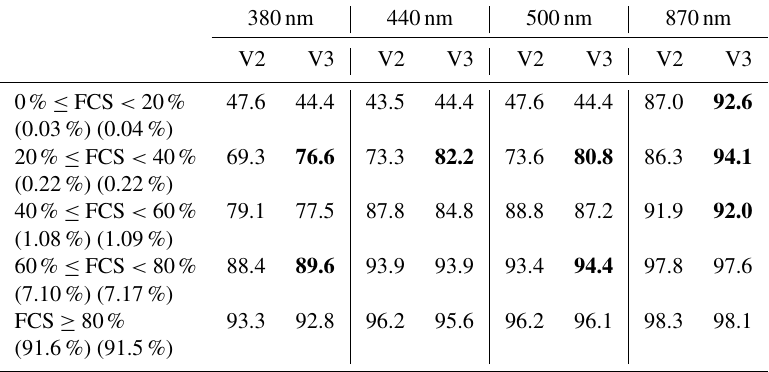
Table 8. Percentage of AOD data within the U 95 limits for each channel and five daily fractions of clear sky (FCS) intervals. In brackets, the relative frequency of each FCS interval is given for AERONET V2 and V3, respectively. In bold are the percentages of V3 that are greater than those of V2.